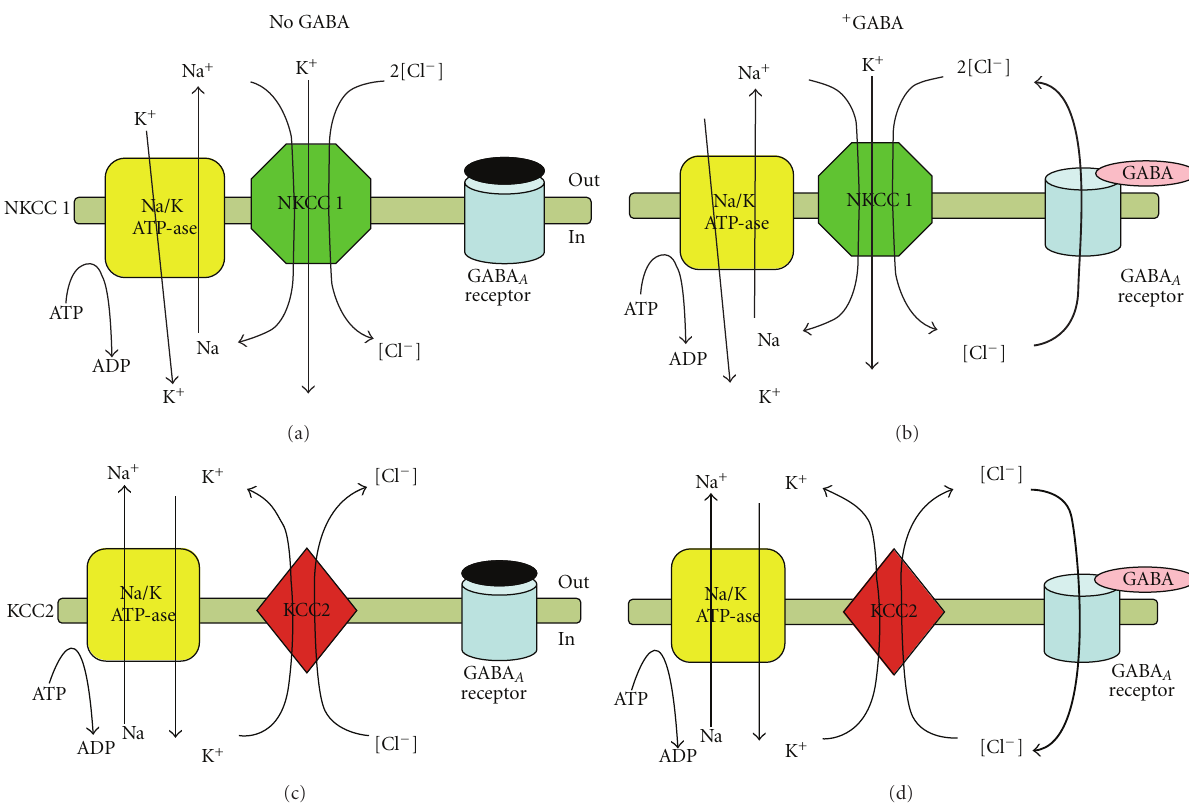
Figure 1: CCCs control GABA A receptor-mediated inhibition. Panels (a) and (b) show the e ff ects of NKCC1 activity in the absence (panel (a)) or presence (panel (b)) of GABA. NKCC1 mediates the electroneutral cotransport of Na + , K + , and 2 Cl − , increasing the intracellular Cl − concentration. As a result, upon binding of GABA upon the GABA A receptor, the channel pore opens and Cl leaves the neuron, causing a depolarization. Panels c and d show the e ff ects of NKCC1 activity on GABA A receptor function in the absence (panel c) or presence (panel d) of GABA. KCC2 in contrast exports K + and Cl − reducing intracellular Cl − . Activation of GABA A receptors therefore results into influx of Cl and hyperpolarizing current. Their function is dependent upon the gradients of Na + and K + , which are controlled by various factors, including background conductances, membrane voltage, and by the Na + /K +